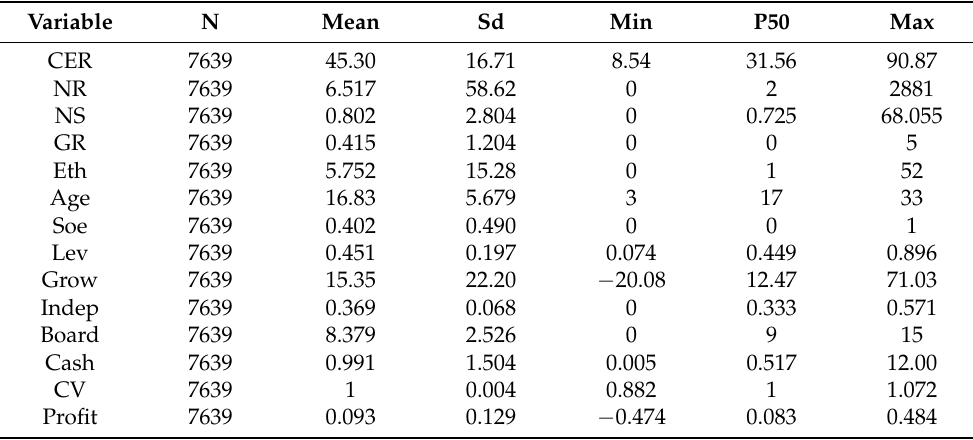
Table 2. The statistical description of